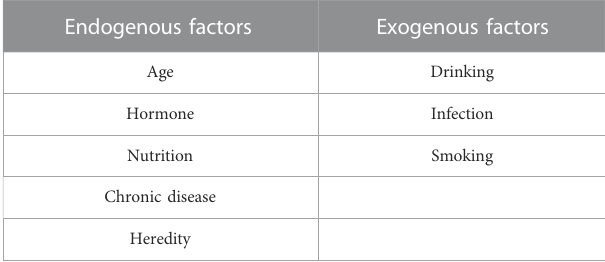
TABLE 1 Factors affecting skin wound